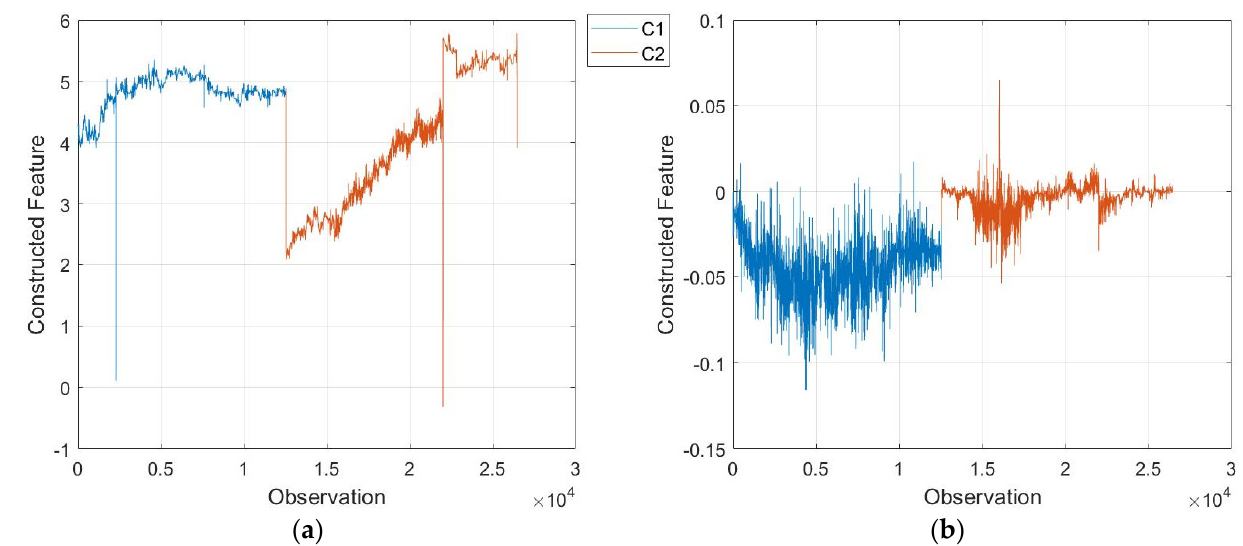
Figure 5. Constructed features through ( a ) classification-based GP and ( b ) clustering-based GP. The